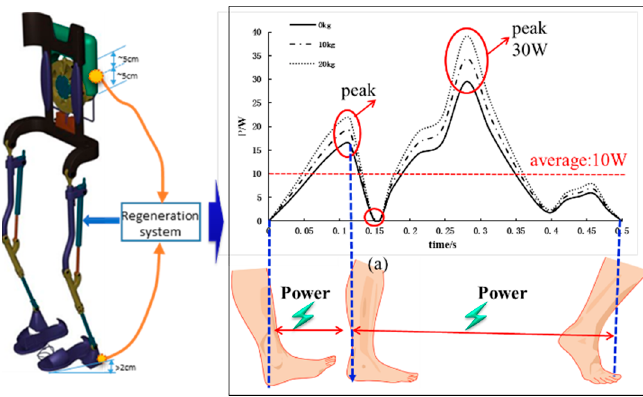
Figure 15. Walking energy harvesting with hydraulic power conversion [133].